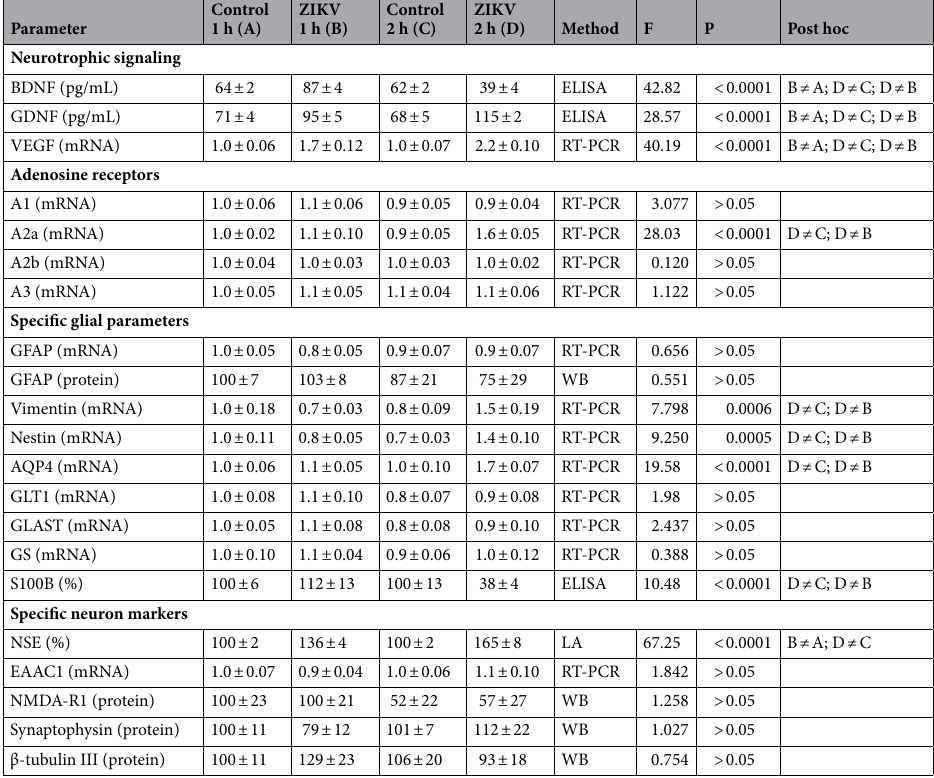
Table 2. Effects of ZIKV on neurotrophic factors, adenosine receptors, and specific neuron and glial parameters. Hippocampal slices from adult Wistar rats were incubated with medium containing ZIKV (10 2 to 10 6 PFU) for an adsorption period of 1 h. Subsequently, this medium was exchanged for fresh saline medium for 1 h or 2 h, and the parameters presented in Table were measured, as described in the “Methods” section. Data are expressed as: (i) pg/mL for ELISA assays, except for S100B ELISA, expressed as the percentage of control; (ii) fold increase for mRNA levels (RT-PCR); (iii) percentages of control for protein levels (Western blotting—WB). Differences among groups were statistically analyzed using one-way analysis of variance (ANOVA), followed by Tukey’s test (n = 6 per group, except for the WB analysis in which at least three experimental determinations were performed). Values of P < 0.05 were considered significant. P values are indicated in the Table. Treatment groups that differ significantly are listed in the Post hoc column. The representative images of WB are in the Supplementary Material (Fig.